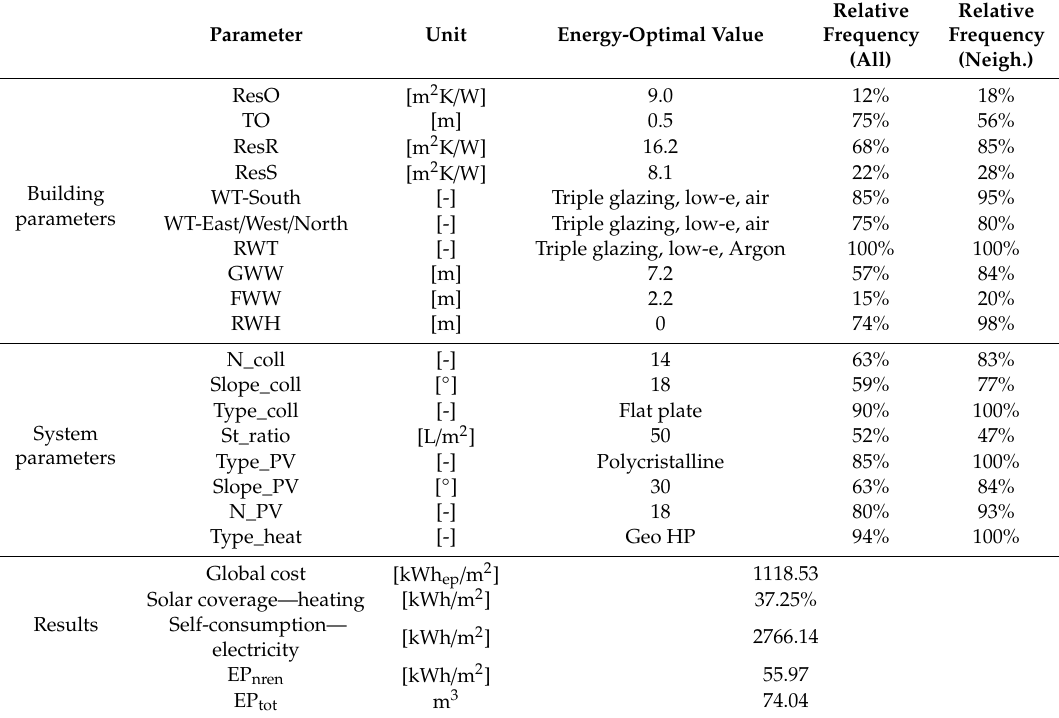
Table 7. Results of the integrated optimization energy